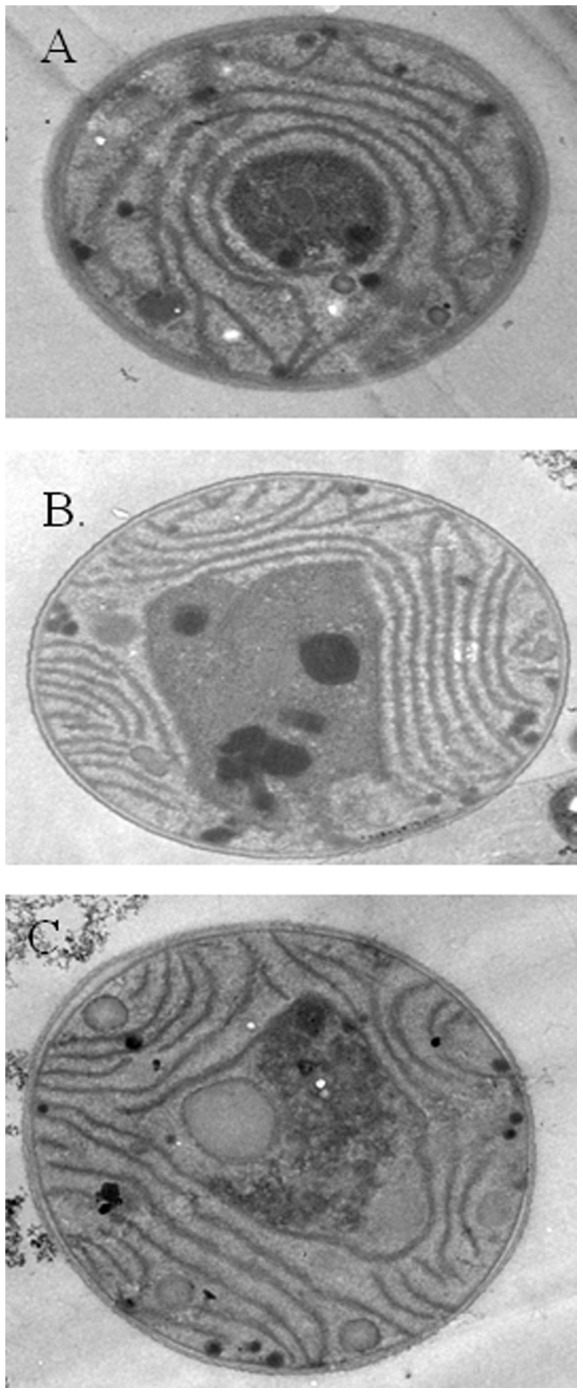
Cell structure of M. aeruginosa in A) the control, B)after contact with E. equisetina extract at a dose of 25 µg for 4 days, and C) after contact with E. equisetina extract at a dose of 50 µg for 6 days.